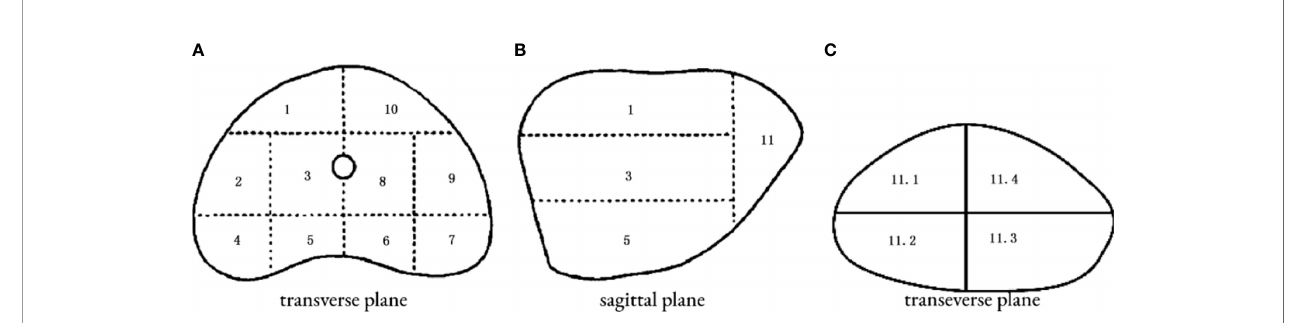
FIGURE 2 | 14 regions of transperineal template – guided prostate biopsy. (A) Transverse plane of the prostate base. 1: Right anterior region; 2: right lateral middle region; 3: right middle region; 4: right posterior-lateral horn region; 5: right back region; 6: left back region; 7: left posterior lateral horn region; 8: left middle region; 9: left lateral middle region; 10: left anterior region. (B) Sagittal plane of the prostate. (C) Transverse plane of the prostate apex. 11.1: Right anterior region; 11.2: right back region; 11.3: left back region; 11.4: left anterior